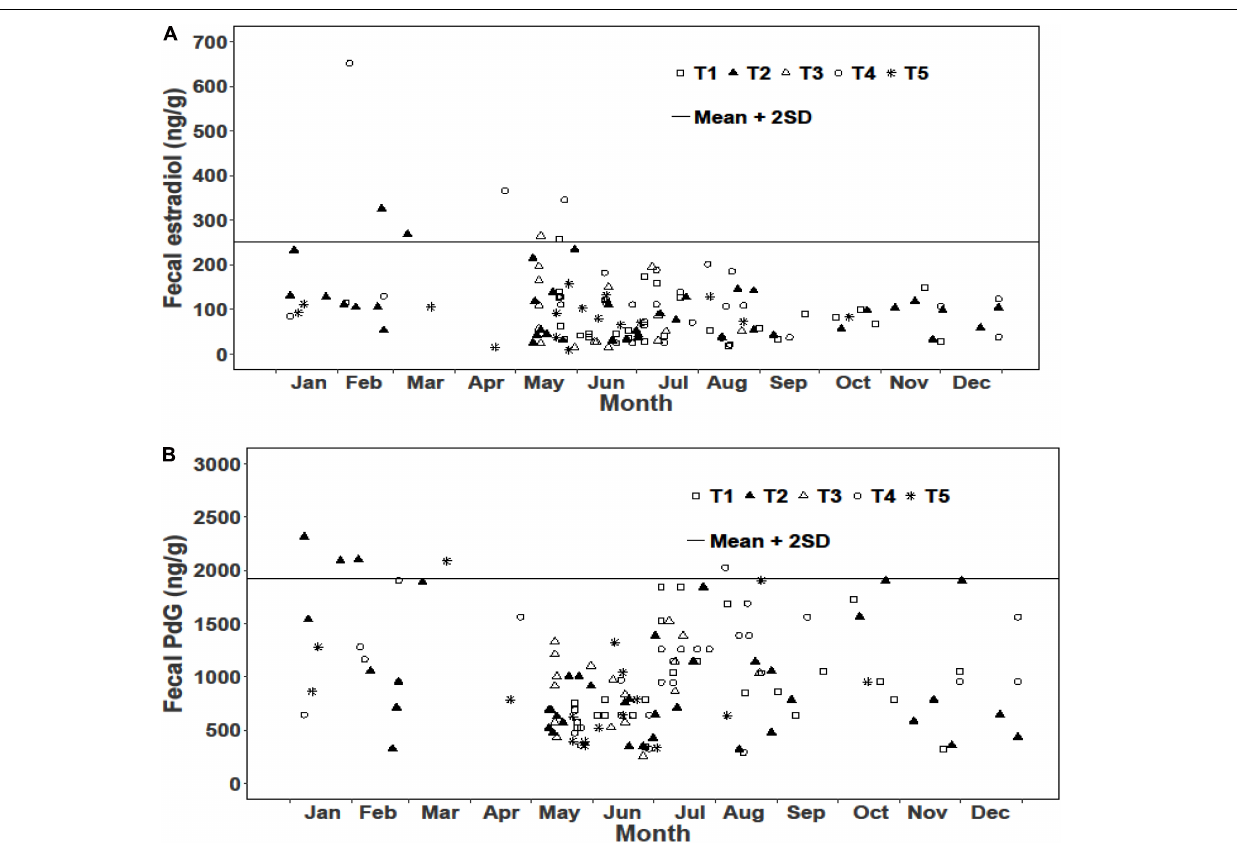
low in goral after May–June till the next estrous in October, indicating